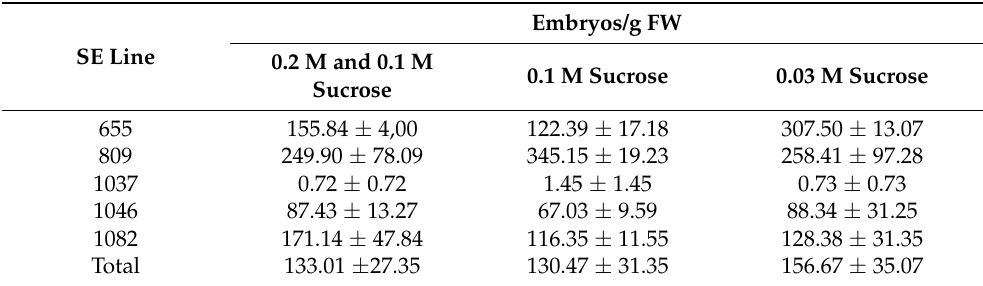
Table 3. Embryo production capacity per one gram of fresh weight of embryogenic tissue. Three cryovials containing ET from the same genotype from every experimental media were stored in LN and three maturations were made from regrowth from every cryovial.